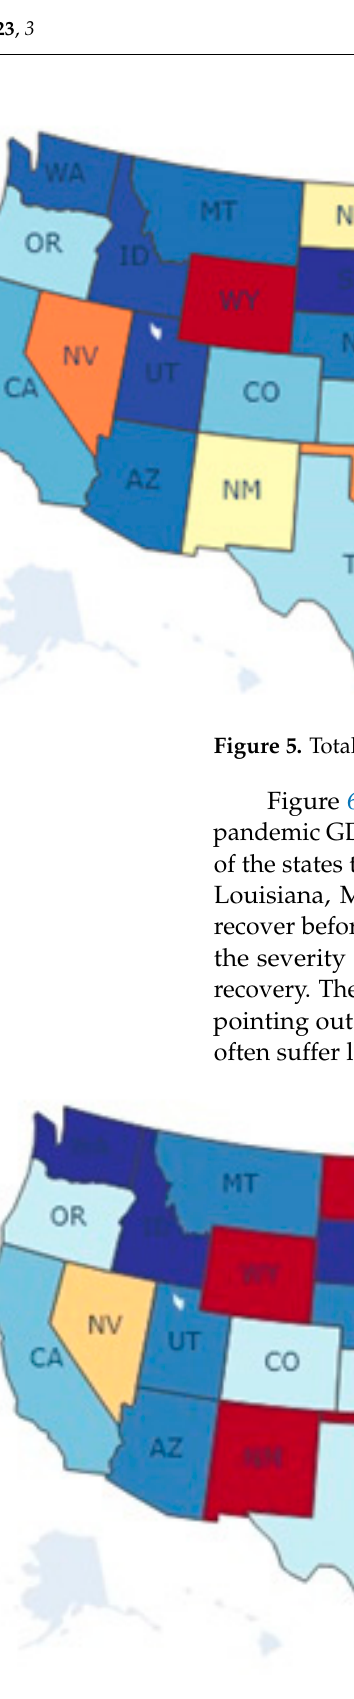
Figure 4. The maximum loss of the quarterly GDP in the pandemic 2020 and 2021 years as a fraction of the pre-pandemic GDP level in the 4th quarter of 2019.